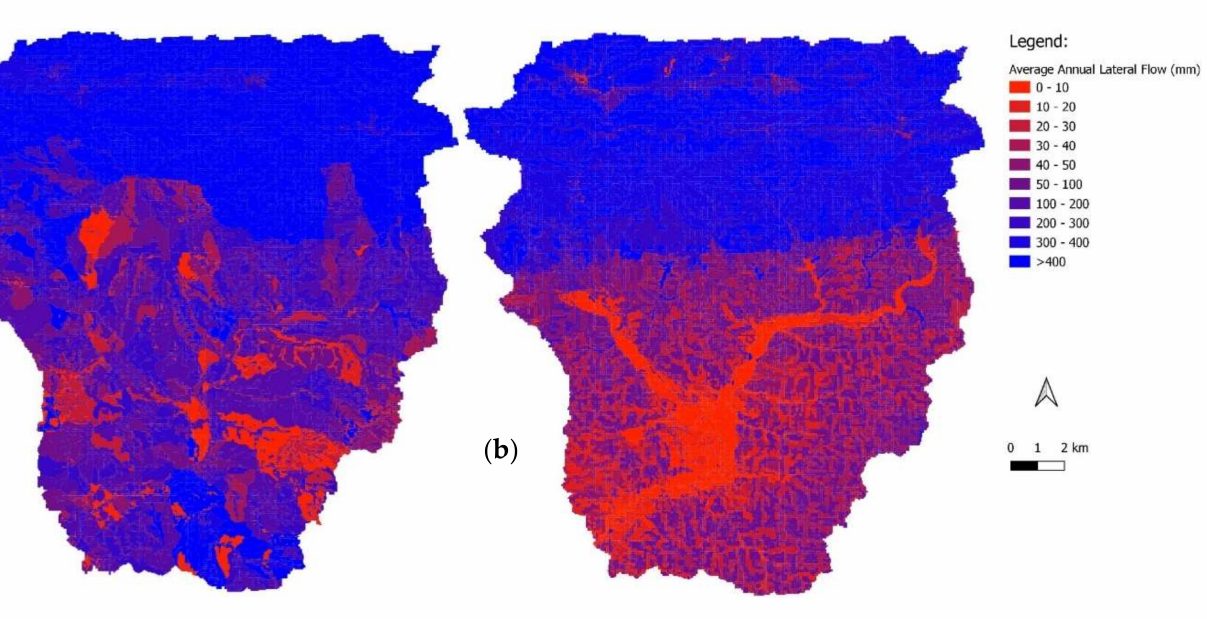
Figure 5. The average annual simulated lateral flow (mm · year − 1 ) at HRU level for the ( a ) LTSM and ( b )